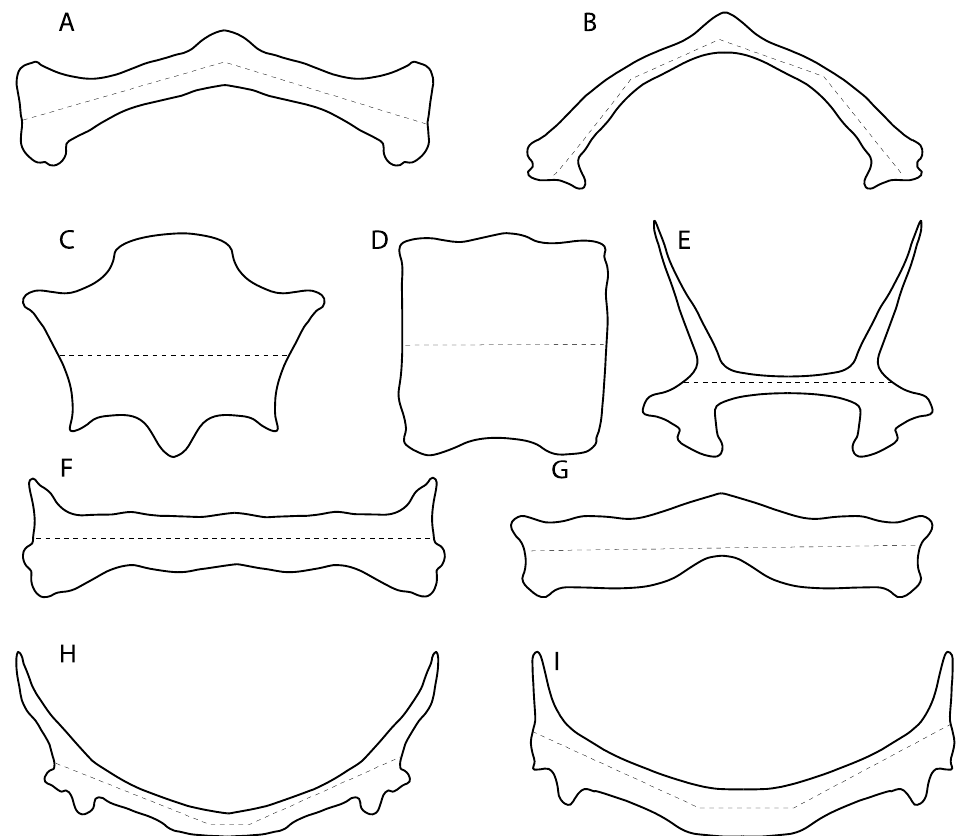
Figure 40. Dorsal view of pelvic girdle. State (0): ( A ) Pristis zijsron (ANSP 101398), redrawn and modified from da Silva et al. Text-Figure 2A [10]; ( B ) Rhina ancylostoma (CAS 56636) redrawn and modified from da Silva et al. Text-Figure 2B in [10]; ( C ) Hexanchus nakamurai (UF 165855 https://sharksrays.org/ (accessed on 25 March 2020)); ( D ) Chlamydoselachus anguineus (UF 44302 https://sharksrays.org/ (accessed on 25 March 2020)); ( E ) † Cyclobatis oligodactylus (NHMUK PV P 601); ( F ) Zapteryx brevirostris (UREJ unpublished data); ( G ) † Asterodermus platypterus (JM-SOS-3647). State (1): ( H ) Torpedo ocellata (AMNH 4128) redrawn and modified from da Silva et al. Text-Figure 3A in [10]; ( I ) Squatina nebulosa (AMNH 258172, https://sharksrays.org/ (accessed on 25 March 2020)). Dashed line highlights the direction of the posterior margin of the pelvic girdle.